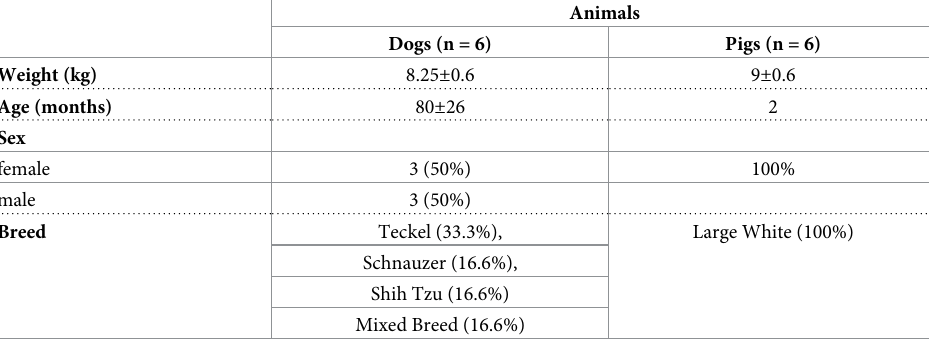
Table 1. Characteristics of the animals selected in the study.